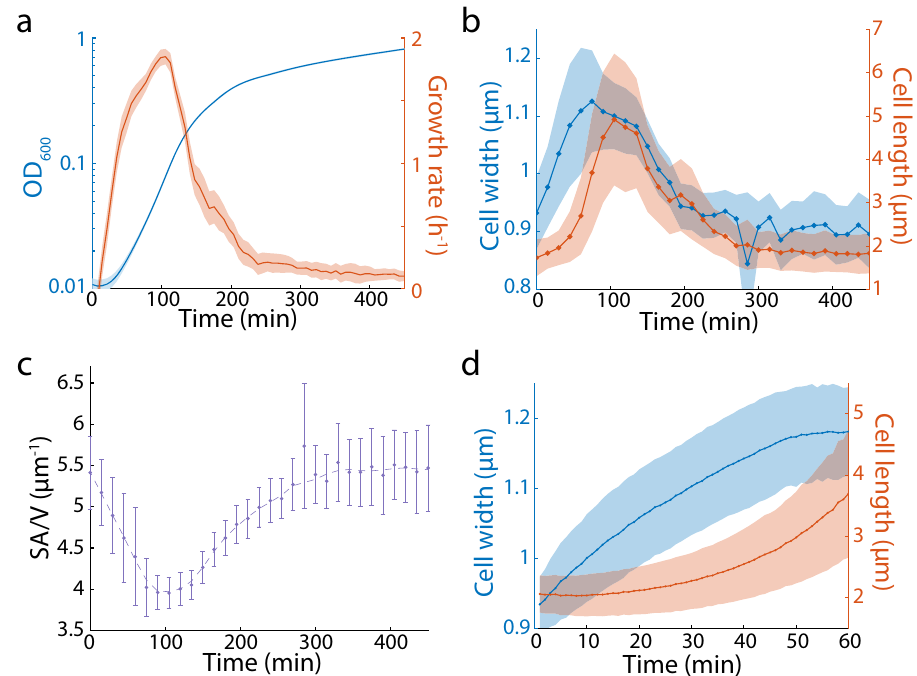
Fig. 1 Cell growth and dimensions undergo complex changes in a batch culture. a Growth curve and the corresponding growth rate of an E. coli MG1655 batch culture after diluting the overnight culture 1:200 into fresh LB. Growth rate peaks at ~1.5 h post dilution, and then slowly decreases. Data points and the corresponding shaded areas are mean ± standard deviation (S.D.) for n = 12 replicates. b Shape growth curves (cell width and length as a function of time) for the same culture in a . Cell width starts to increase earlier compared to length. Data points and the shaded areas are mean ± S.D. for n > 200 single cells. c SA/V as a function of time for the same culture in b . SA/V decreased as cells resume growth, and then slowly increased back to the initial value when cell growth slowed down. Data points are mean ± S.D. with n > 200 single cells, and the dashed line is smoothed as a guide to the eye. d Single-cell time-lapse imaging of stationary-phase MG1655 cells diluted onto an agarose pad containing fresh LB. Each cell exhibited similar width and length dynamics as in the bulk culture in b . Solid lines and the corresponding shaded areas are mean ± S.D. with n = 146 single cells. Source data are provided as a Source Data fi